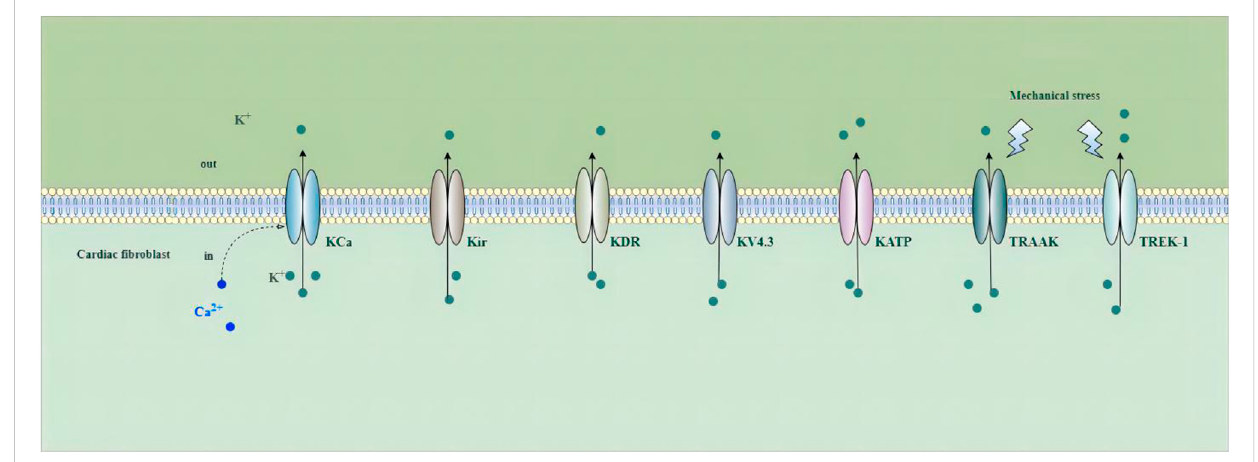
FIGURE 2 Potassium channels in cardiac fi broblasts. Abbreviations; KCa, Ca 2+ -activated K + channel; Kir, inward recti fi er K + channel; KDR, delayed recti fi er K + channel; KV4.3, voltage-gated K + channel 4.3; KATP, ATP-sensitive potassium channel; TRAAK, Tandem of P-domains in a weak inward-rectifying K + channel (TWIK)-related arachidonic acid activated K + channel; TREK-1, TWIK-related K + channel 1; See text for